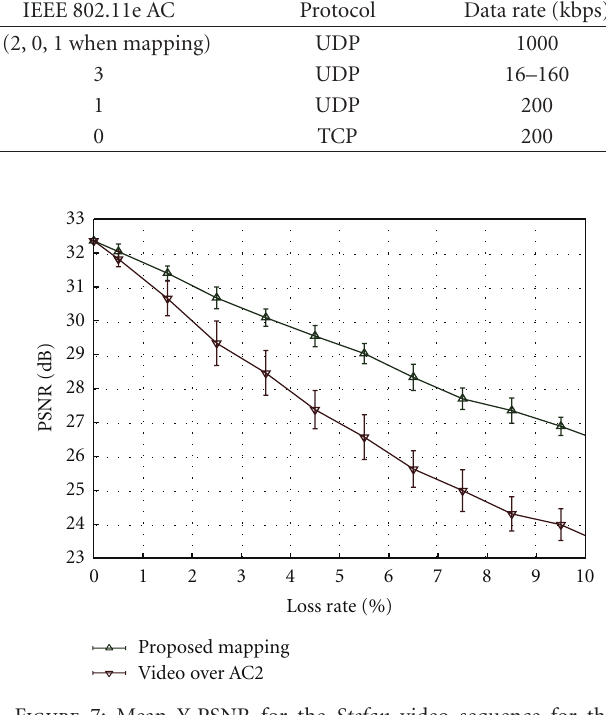
Figure 7: Mean Y-PSNR for the Stefan video sequence for the simulated network